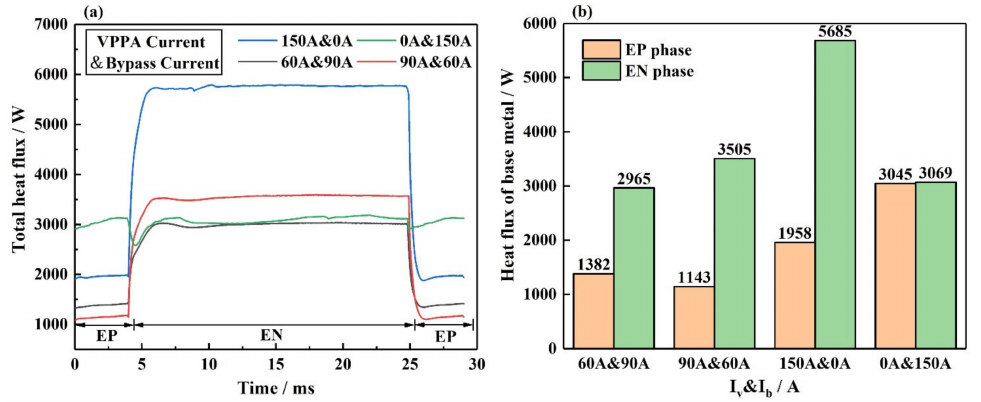
Figure 12. Schematic diagram of energy balance at EN and EP phases, ( a ) EP, ( b ) EN.